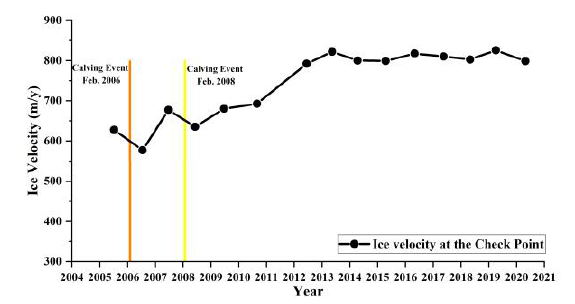
Figure 4 . Evolution of the annual ice velocity at the Check Point (Figure 3) from 2005 to